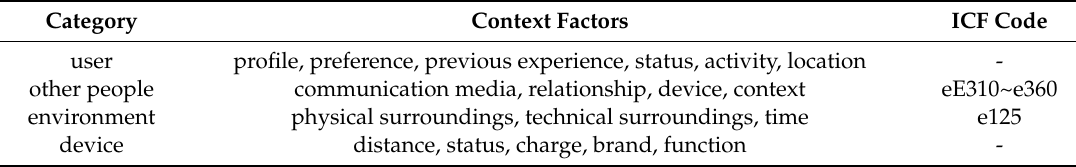
Table 5. Contextual taxonomies of IT